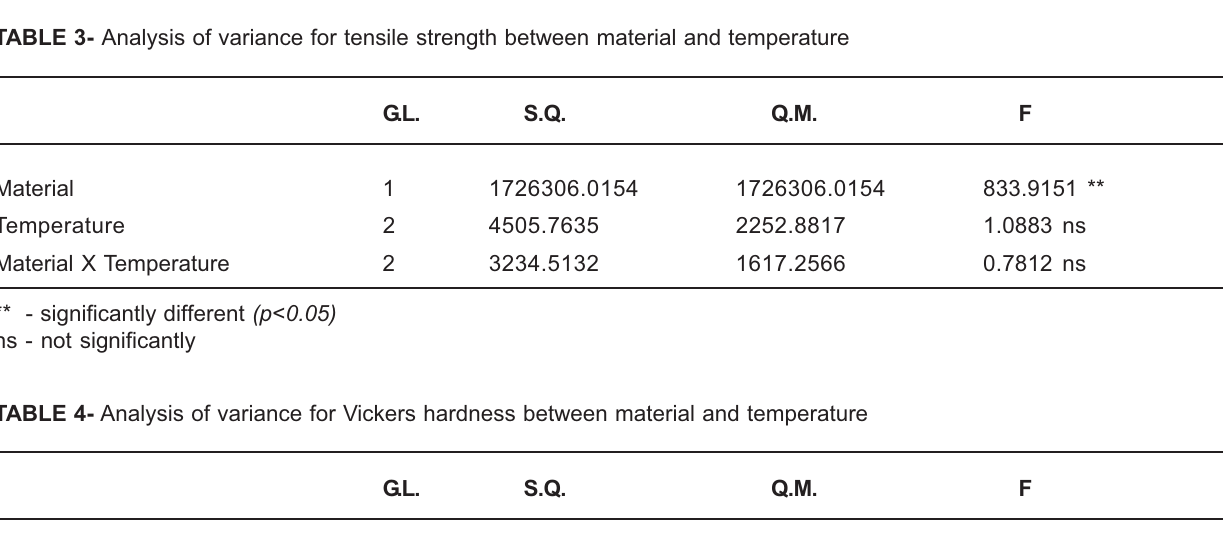
TABLE 3- Analysis of variance for tensile strength between material and temperature